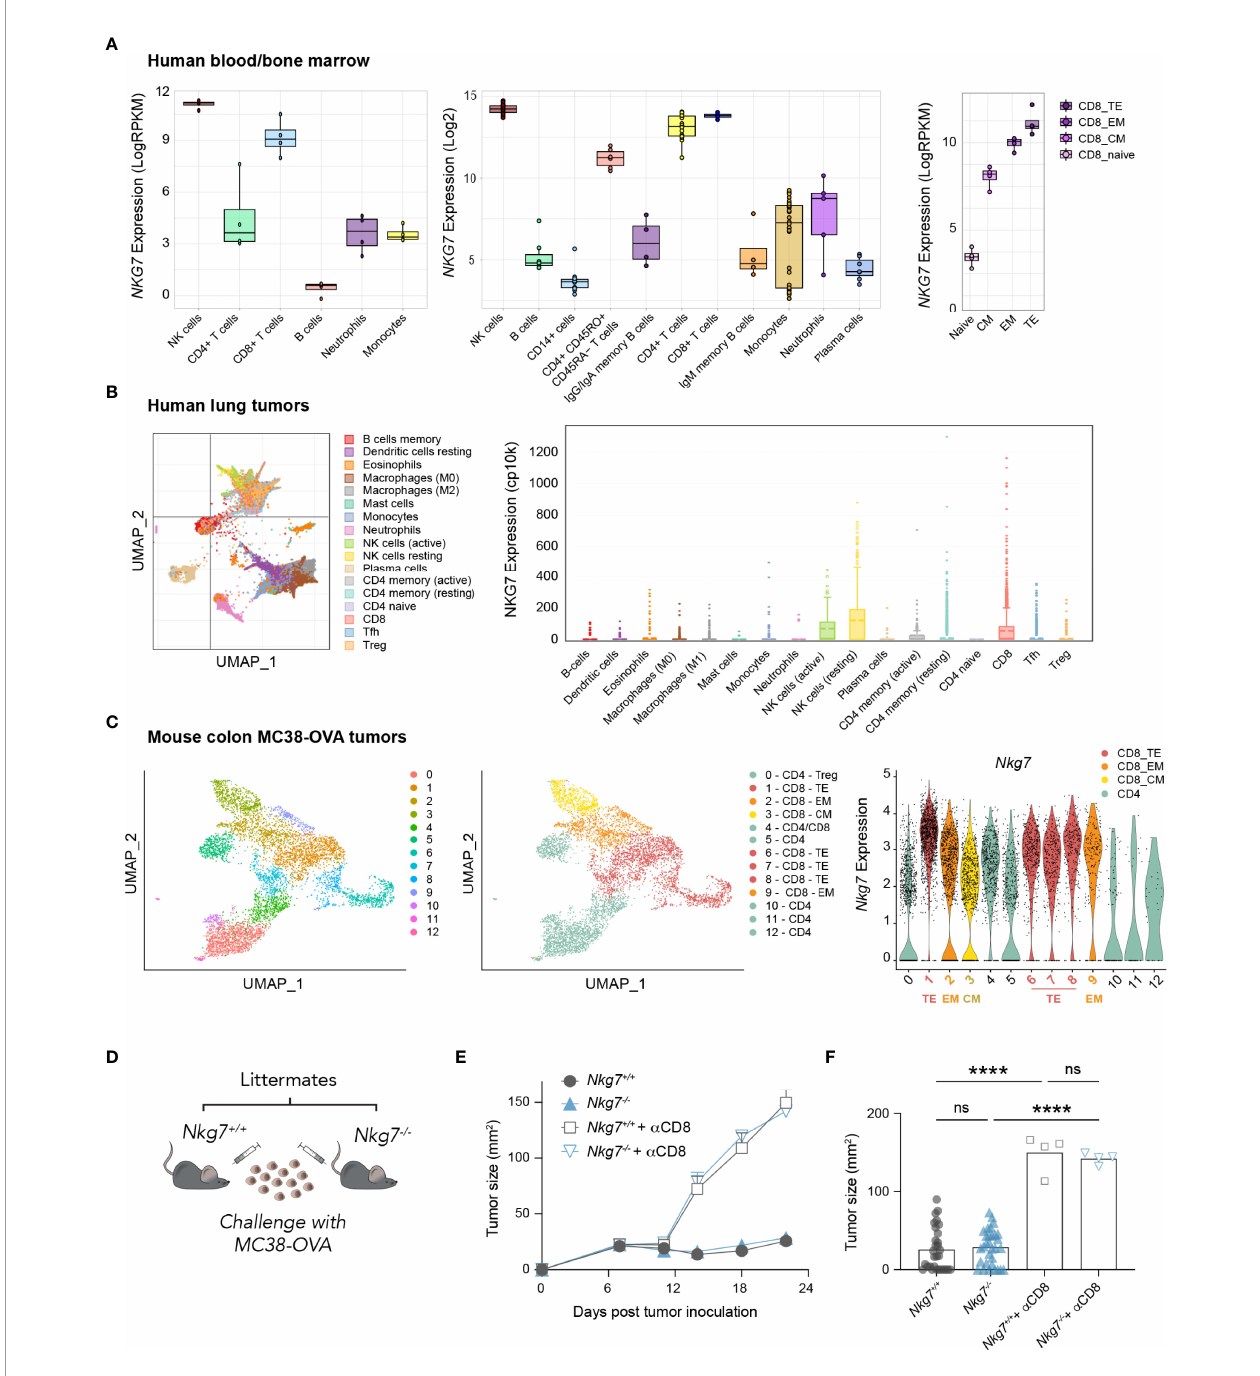
FIGURE 1 | NKG7 is highly expressed in tumor-in fi ltrating CD8+ effector T cells but is not required for CD8+ T cell-mediated control of MC38-OVA tumors in vivo . (A – C) Analysis of bulk and single-cell RNA-seq and CITE-seq datasets available through the GEO. TE – Terminal Effector; EM – Effector Memory; CM – Central Memory (A) Bulk RNA-seq showing NKG7 expression on sorted cells from healthy human donor whole blood (left panel; GSE60424 (30), PBMCs or bone marrow (middle panel; GSE22886 (31), and PBMCs (right panel; GSE107011 (29). (B) Single cell RNA-seq showing NKG7 expression across different tumor-in fi ltrating immune subsets in human lung carcinoma (GSE127465 (32). (C) Single cell CITE-seq showing Nkg7 expression in tumor in fi ltrating T cells from MC38-OVA tumors harvested 10 days post subcutaneous tumor inoculation in C57BL/6 mice (GSE182664 (14). (D) Schematic of in vivo tumor growth study. MC38-OVA cells were implanted subcutaneously in Nkg7 +/+ or Nkg7 -/- littermates with or without CD8 depletion antibodies administered starting the day prior to tumor inoculation. (E) Tumor growth, error bars show SEM. (F) Tumor size on day 22 post tumor inoculation, data is pooled from 4 independent experiments, One-way ANOVA (n = 4-31). ns – not signi fi cant, **** P